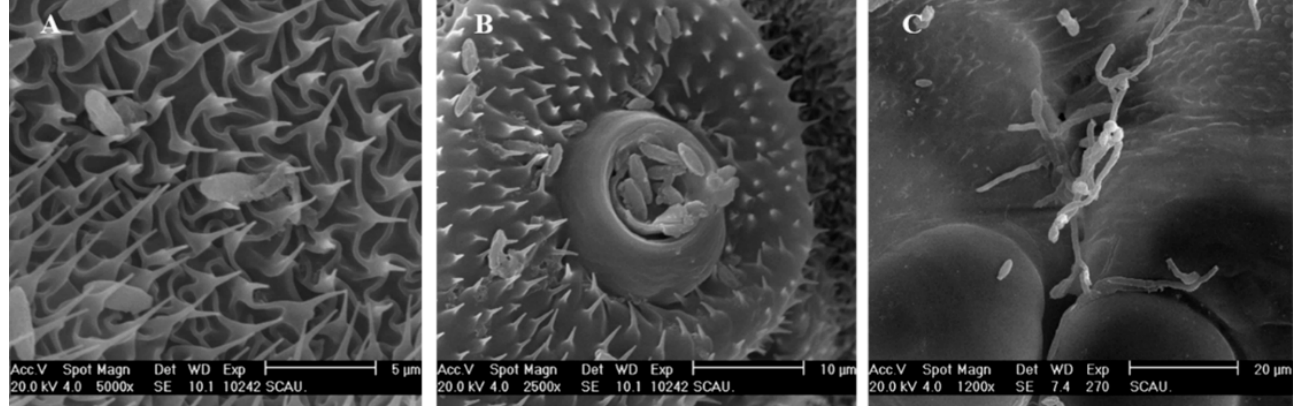
Figure 2. Cuticle topography of Plutella xylostella larvae with conidial adhesion. ( A ) Acanthoid surface topography; ( B ) Spinous surface topography; ( C ) Gentle surface topography.